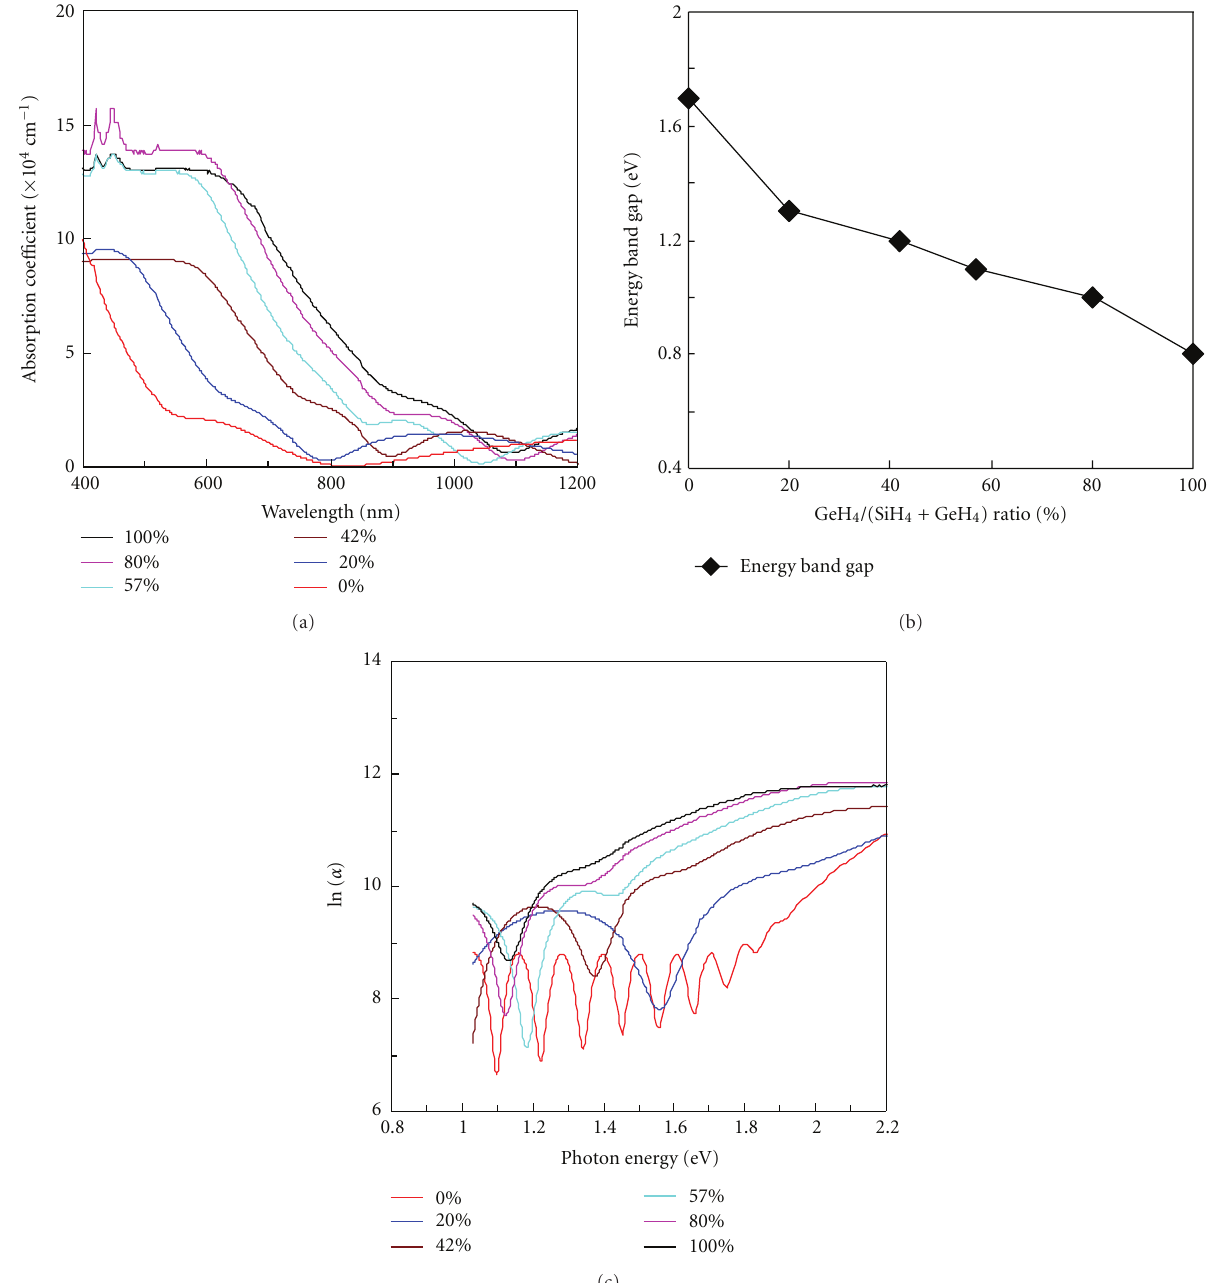
Figure 3: (a) The spectral dependence of the absorption coe ffi cient for the SiGe films with di ff erent gas ratios. (b) The Tauc energy band gap as a function of the gas ratio. (c) The Urbach plots of the SiGe films with di ff erent gas ratios. soaking was performed under one-sun light intensity using a metal halide lamp at 50 ◦ C for 500 h. The intensity was maintained at a level so that a reference Si solar cell generated the same current under a Xe-lamp